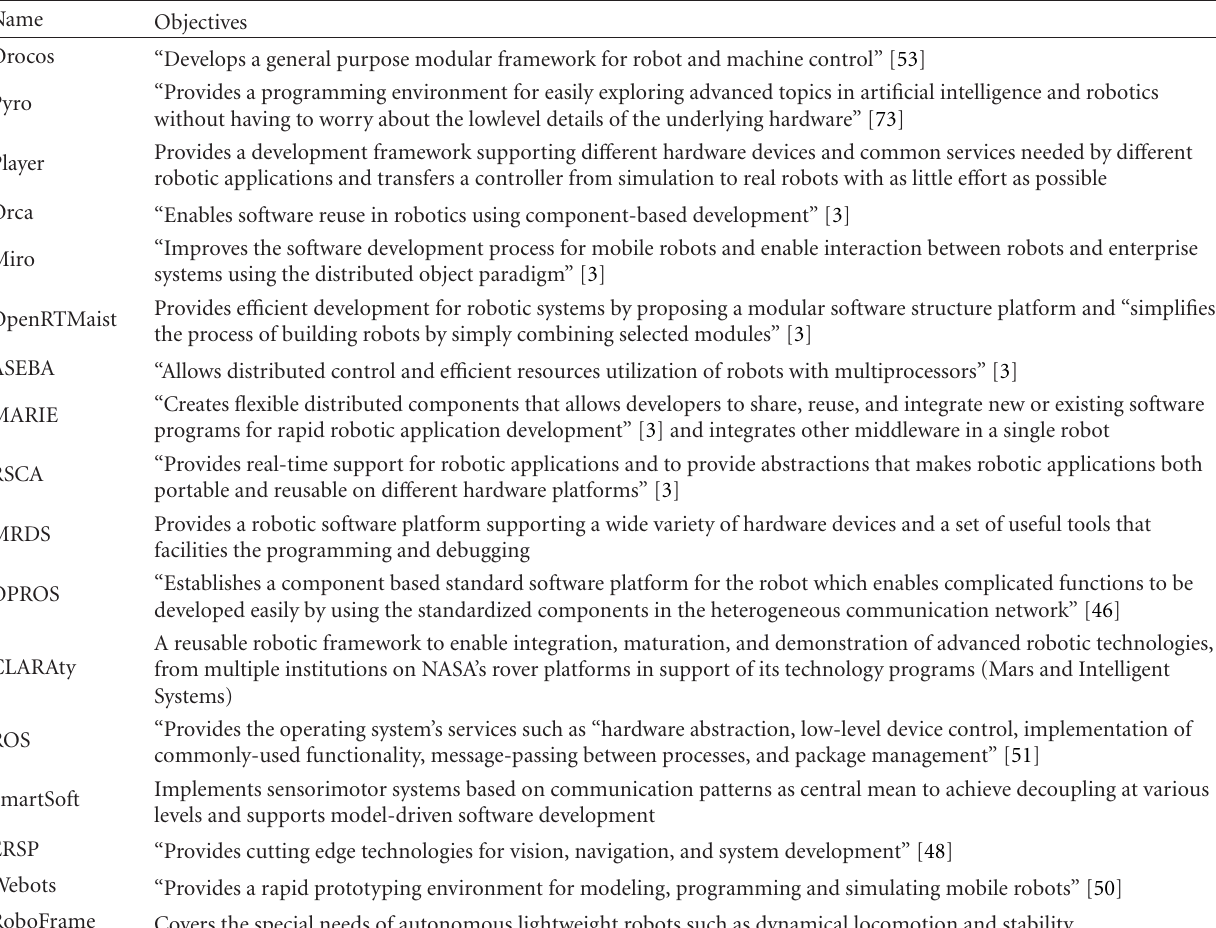
Table 1: Objectives of several robotics middleware